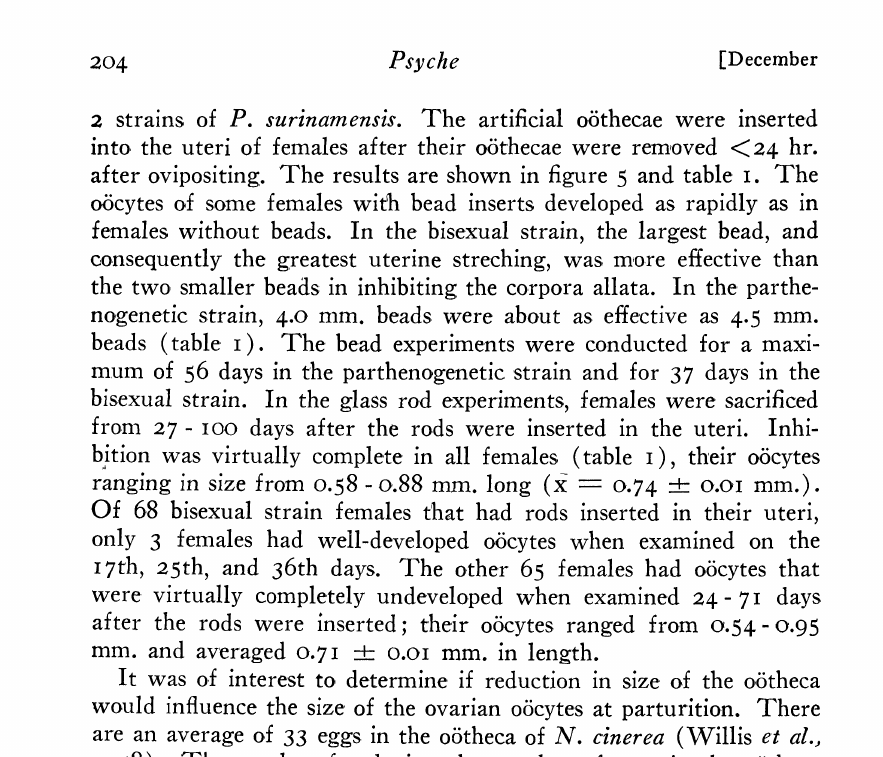
Fig. 5. Effect of distention of the uterus with glass beads o.n inhibition of the corpora allata during gestation in two strains of P. surinamensis. Solid circles Carrying o6thecae (controls). Each point represents one female or is an average value of 2-5 females. Bisexual--N 107" oarthenogenetic--N 75. Open circles O.6thecae removed <24 hr. after ovipositing; no glass beads inserted in uteri. Bisexualmg-16 females per point (N 189); parthenogeneticm4-14 females per point (N 96). The 3.5 mm.